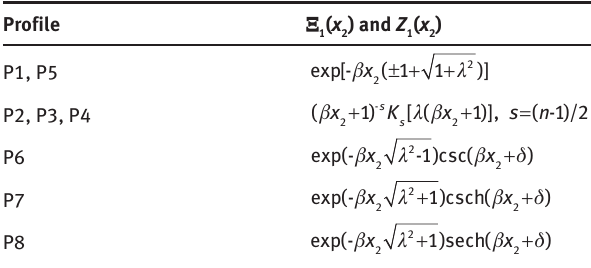
Table 5: Solution of Ξ profiles.